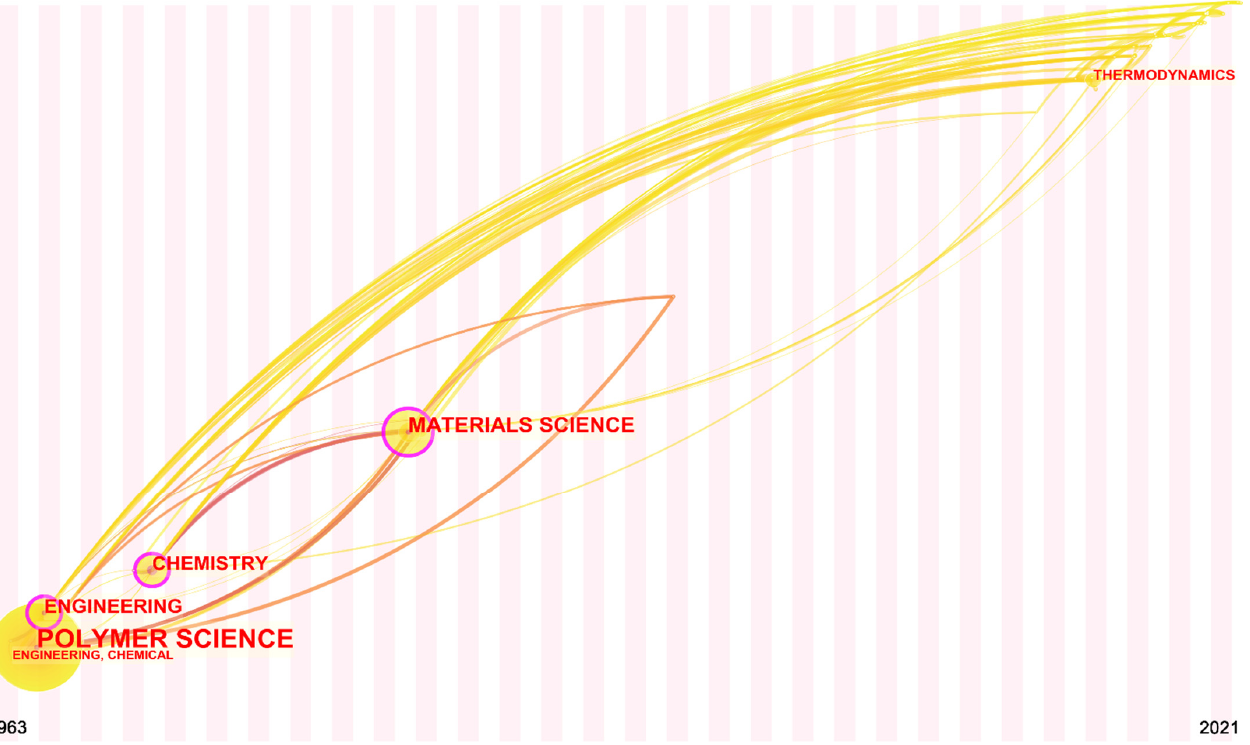
Figure 6. Time-zone view of research categories for flame-retardant RPUF.